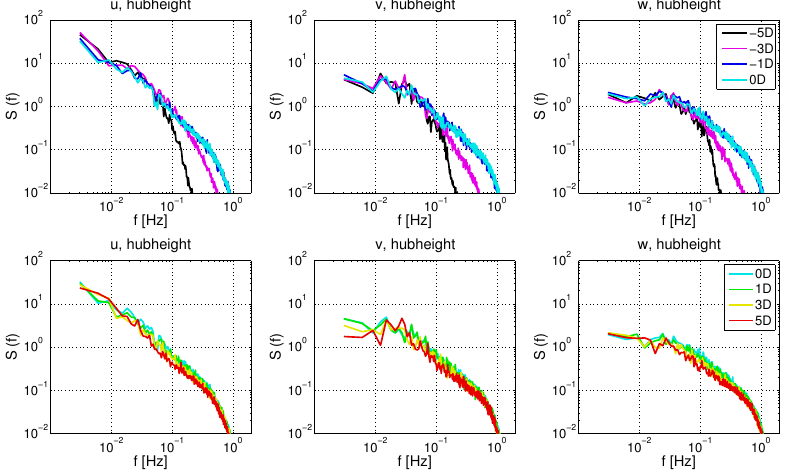
Figure 5. Power spectra for the three free-stream turbulence components; different